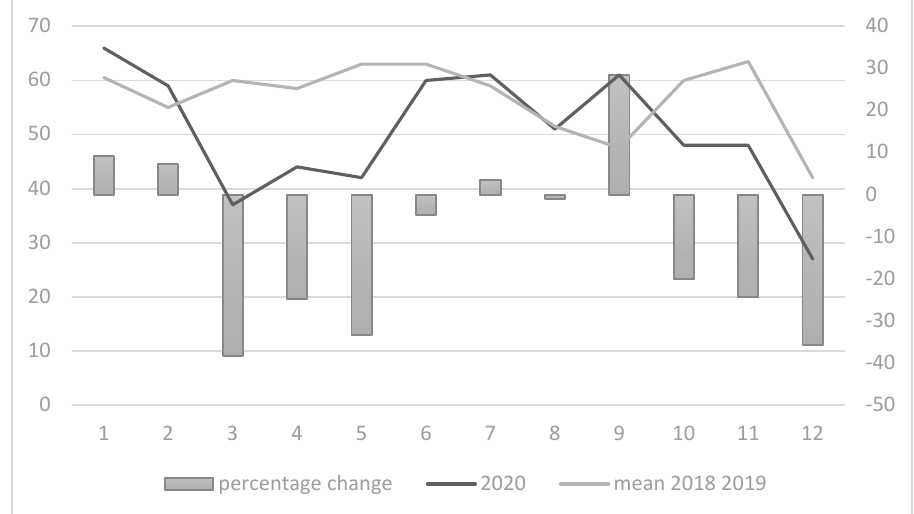
Figure 1. Monthly differences in colorectal cancer